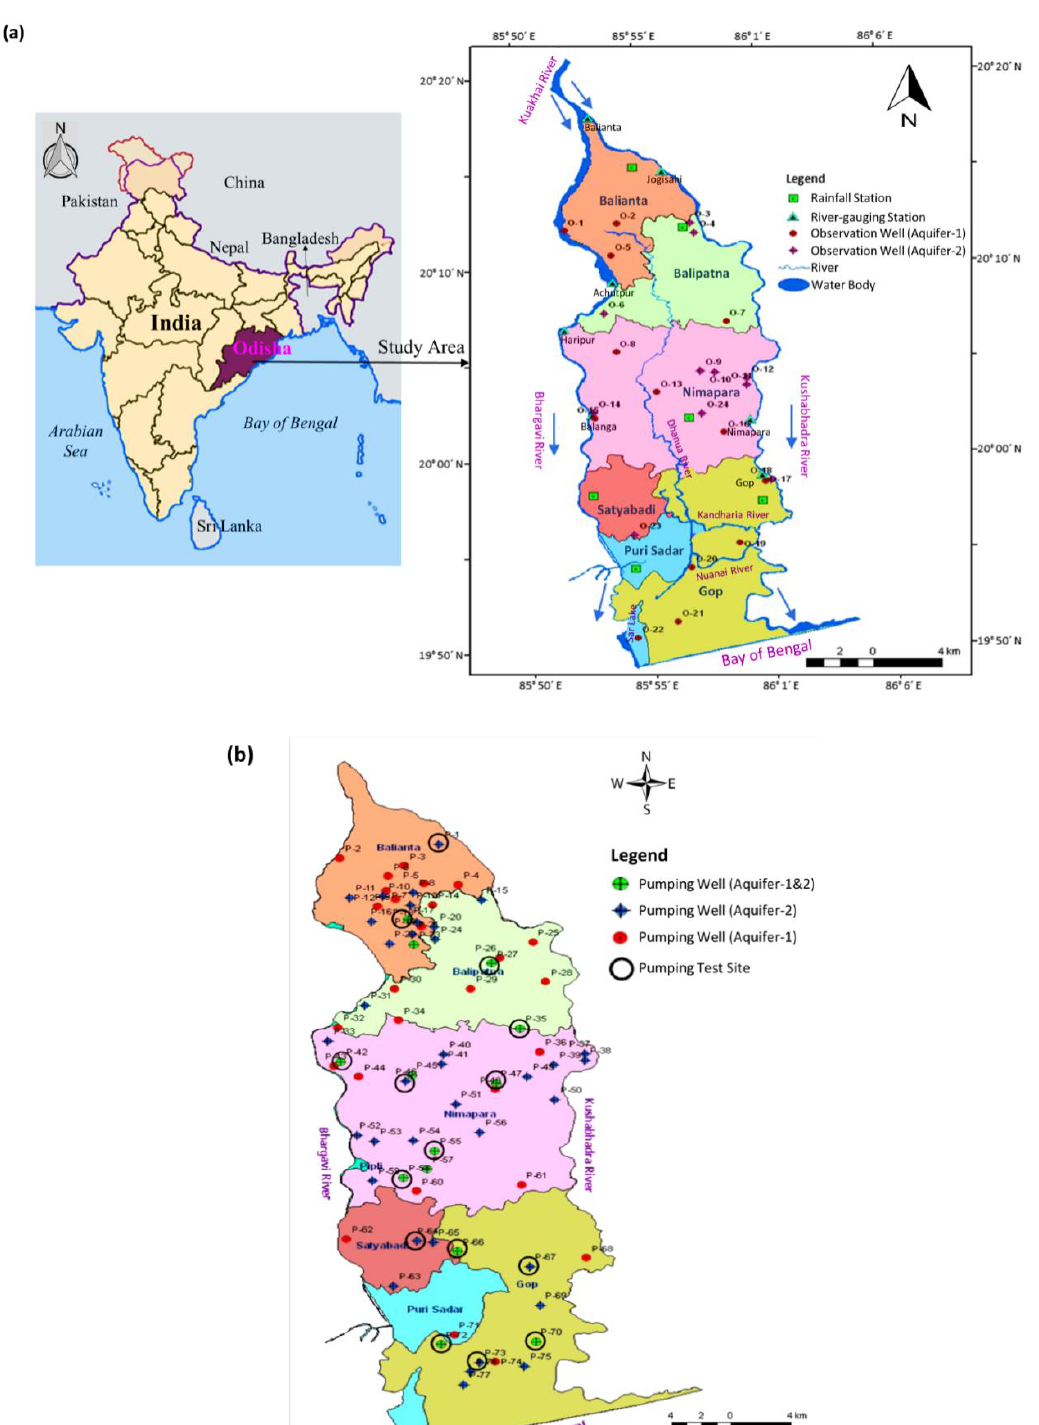
Figure 1. (a ) Location of the study area with rainfall stations, river gauging stations and observation wells; and ( b ) pumping wells in the unconfined aquifer (Aquifer-1) and confined aquifer (Aquifer-2) (modified from